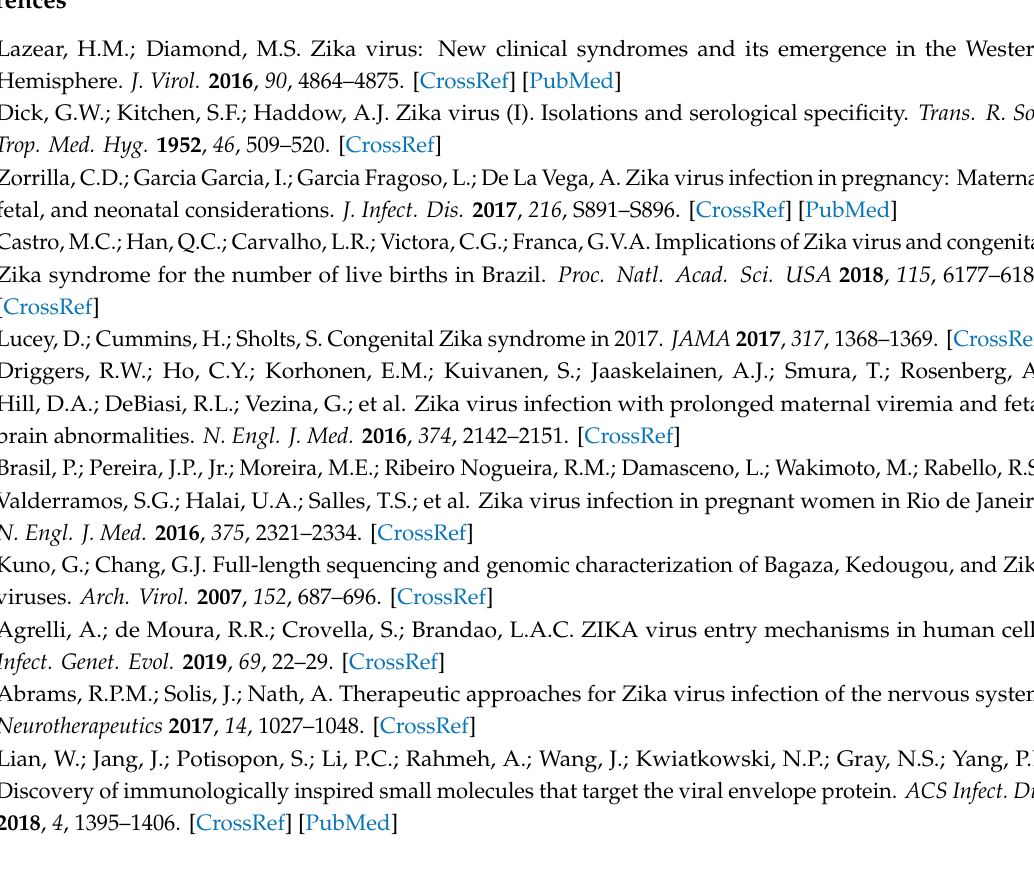
Figure S1: Association between inhibitory activity of natural products against ZIKV strain PAN2016 and their cytotoxicity. Figure S2: Association between inhibitory activity of natural products against ZIKV strain PRVABC59 and their cytotoxicity. Figure S3: Multiple sequence alignment of amino acid (aa) sequences of E protein of 10 ZIKV strains and DENV-1-3 human strains used in this